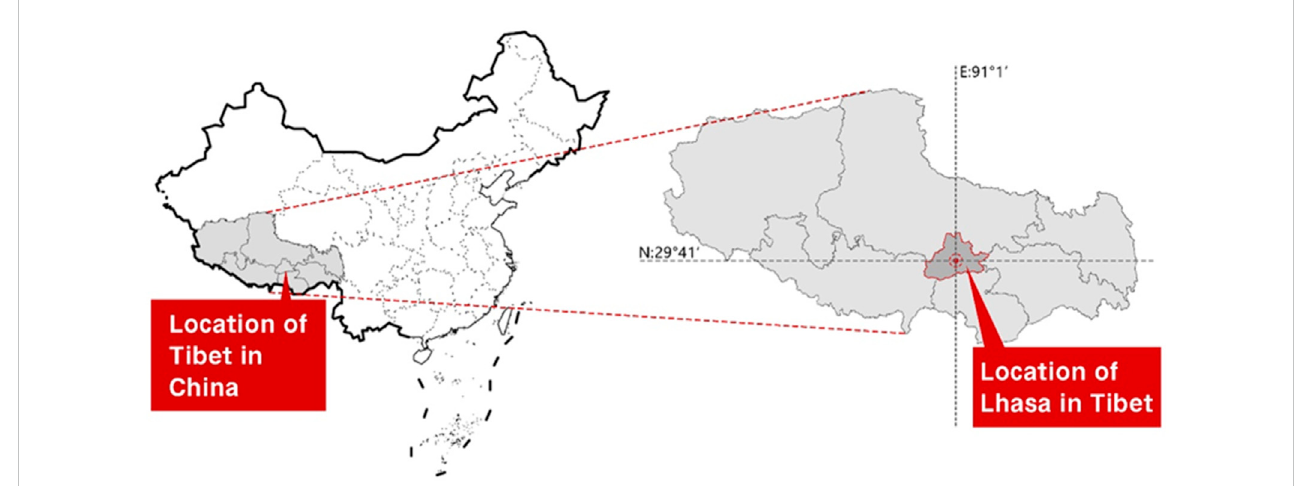
FIGURE 1 Geographical location of Lhasa.